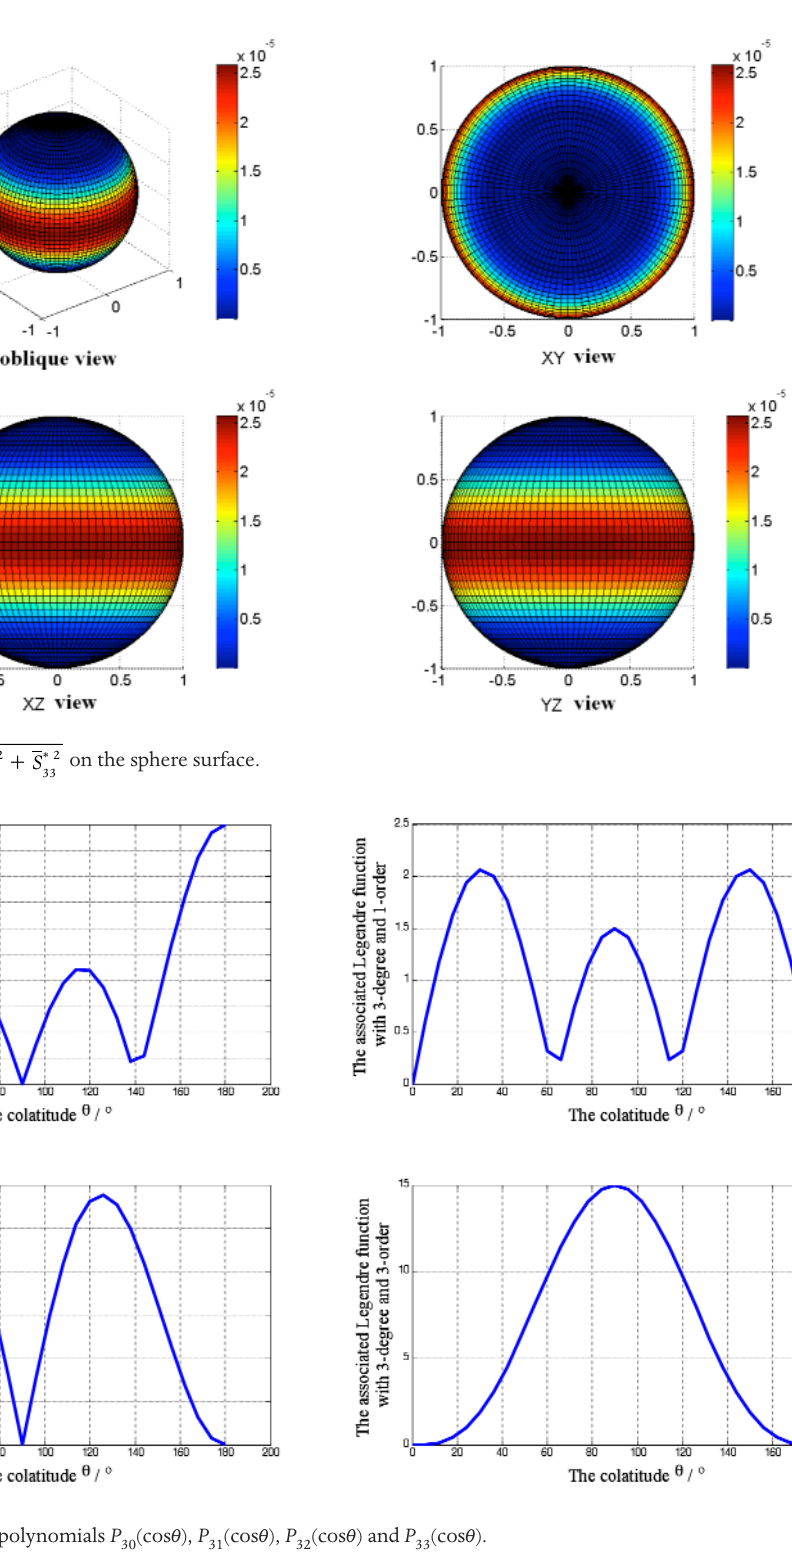
Figure 13. The associated Legendre polynomials P